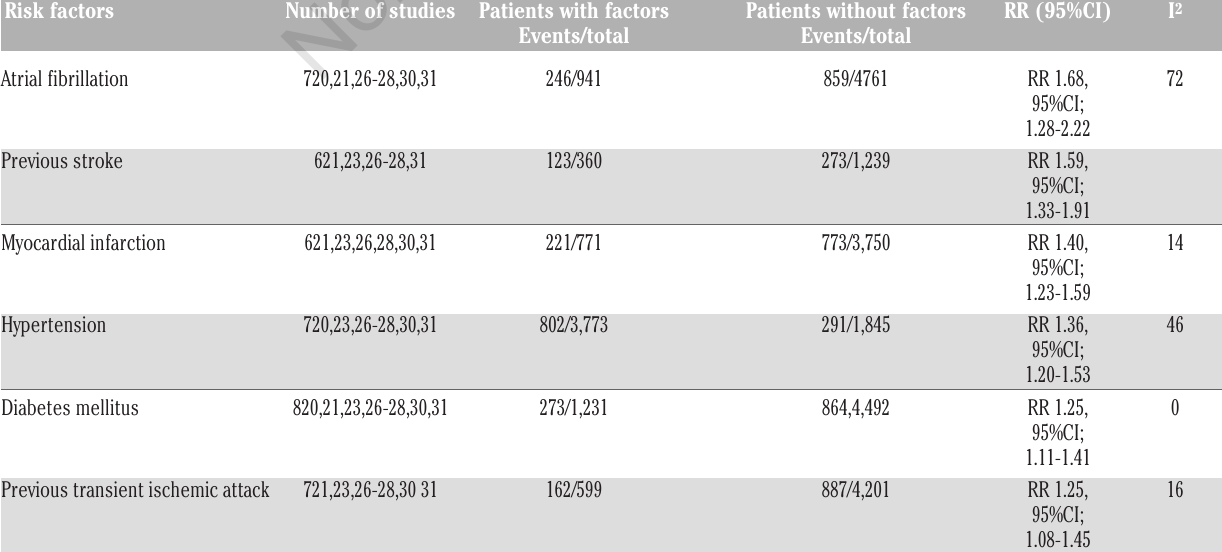
Table 2. Pooled risk ratios for factors associated with post-stroke